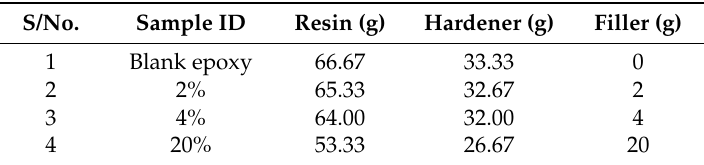
Table 1. Recipe for composite